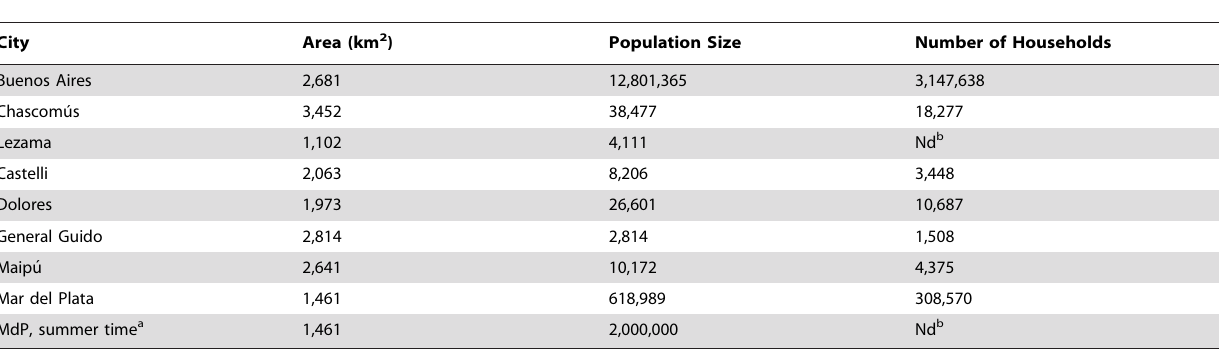
Table 1. Characteristics of cities connected by Route N u 2 in Buenos Aires Province (http://www.censo2010.indec.gov.ar/).